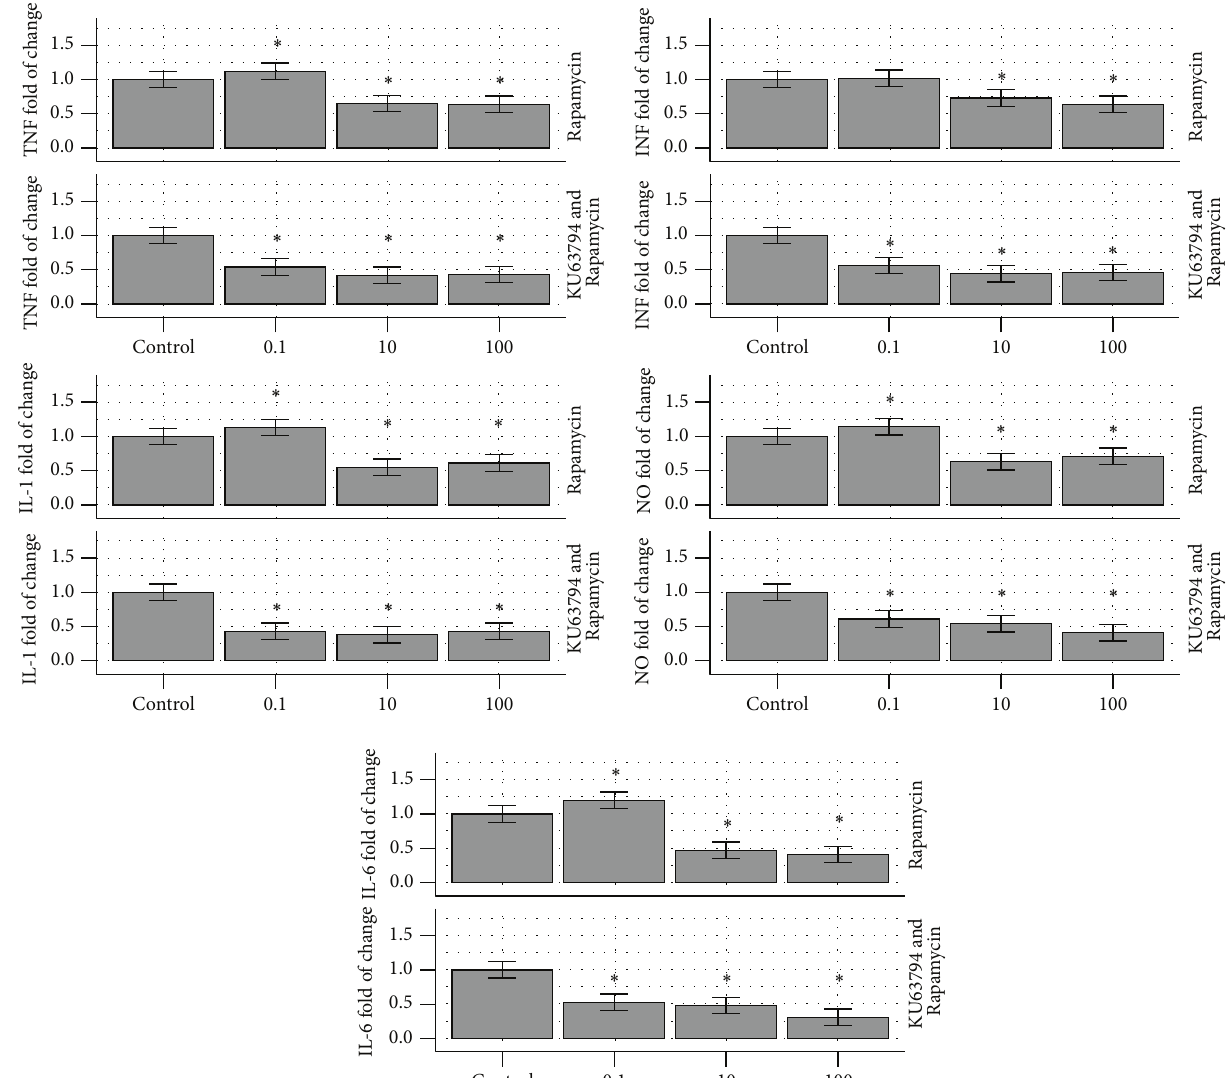
Figure 3: A graphic representation of Table 3. It indicates the reduction from the control of RAW264.7 macrophages inflammatory response of TNF, IL-1, IL-6, INF, and NO, respectively, in the presence of 0, 0.1, 10, and 100 ng/mL Rapamycin (up) and Rapamycin and KU63794 5 ng/mL (down). The graphs are depicted as a percent of the control response, that is, without Rapamycin (up) or Rapamycin and KU63794 (down). TNF: tumor necrosis factor, IL-1: interleukin 1, IL-6: interleukin 6, INF: interferon, and NO: nitric oxide.